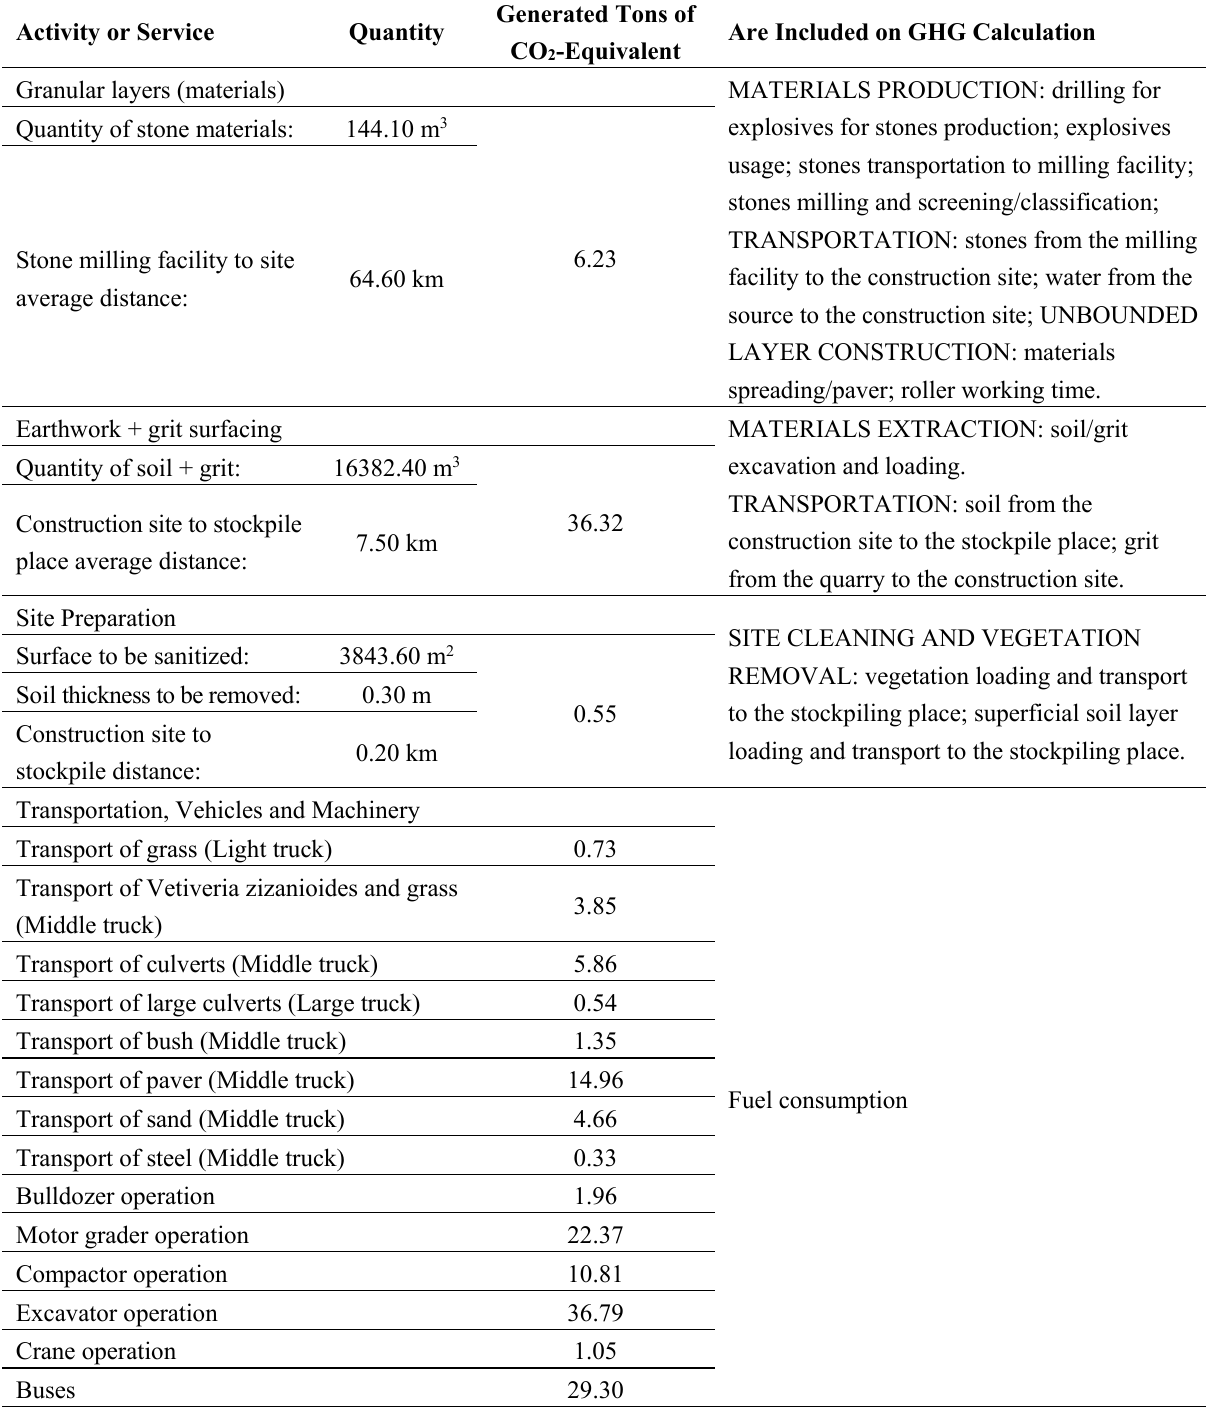
Table 1. Total GHG emission generated on Santa Rosa de Lima